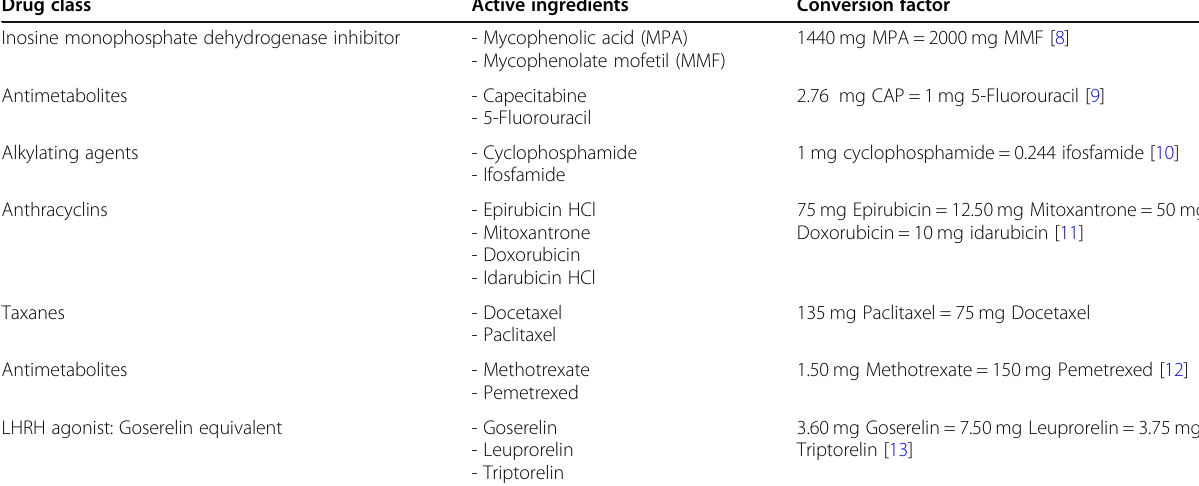
Table 1 Active ingredients in each class of anticancer drugs and the factors used in the conversion Drug